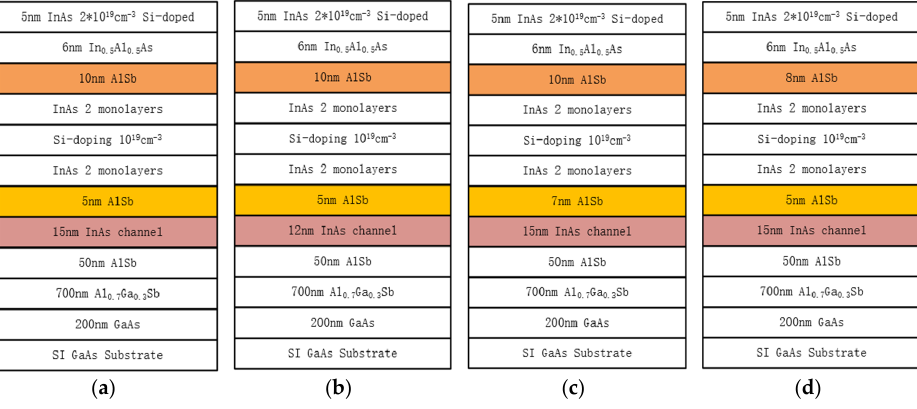
Figure 6. Epitaxy structure diagram of 4 different samples: ( a ) is for Sample #1, ( b ) is for Sample #2, ( c ) is for Sample #3, and ( d ) is for Sample #4.